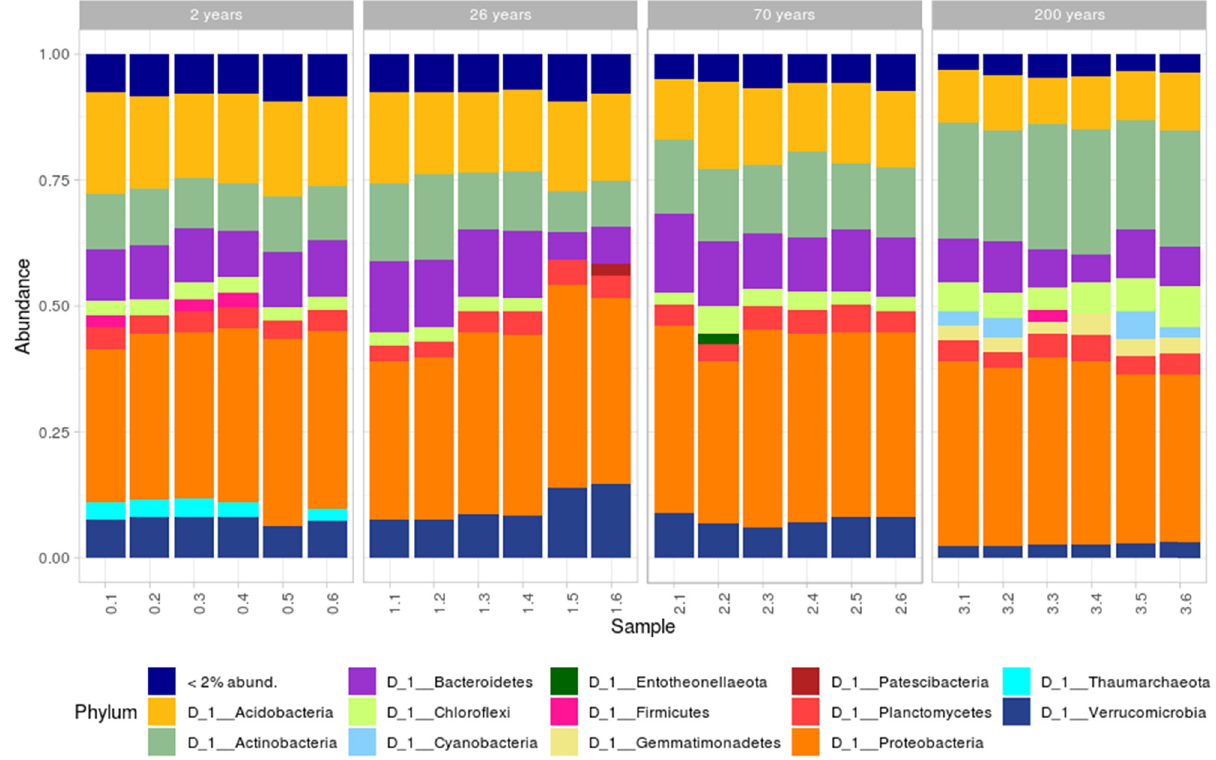
Figure 3: Taxonomy composition of soil